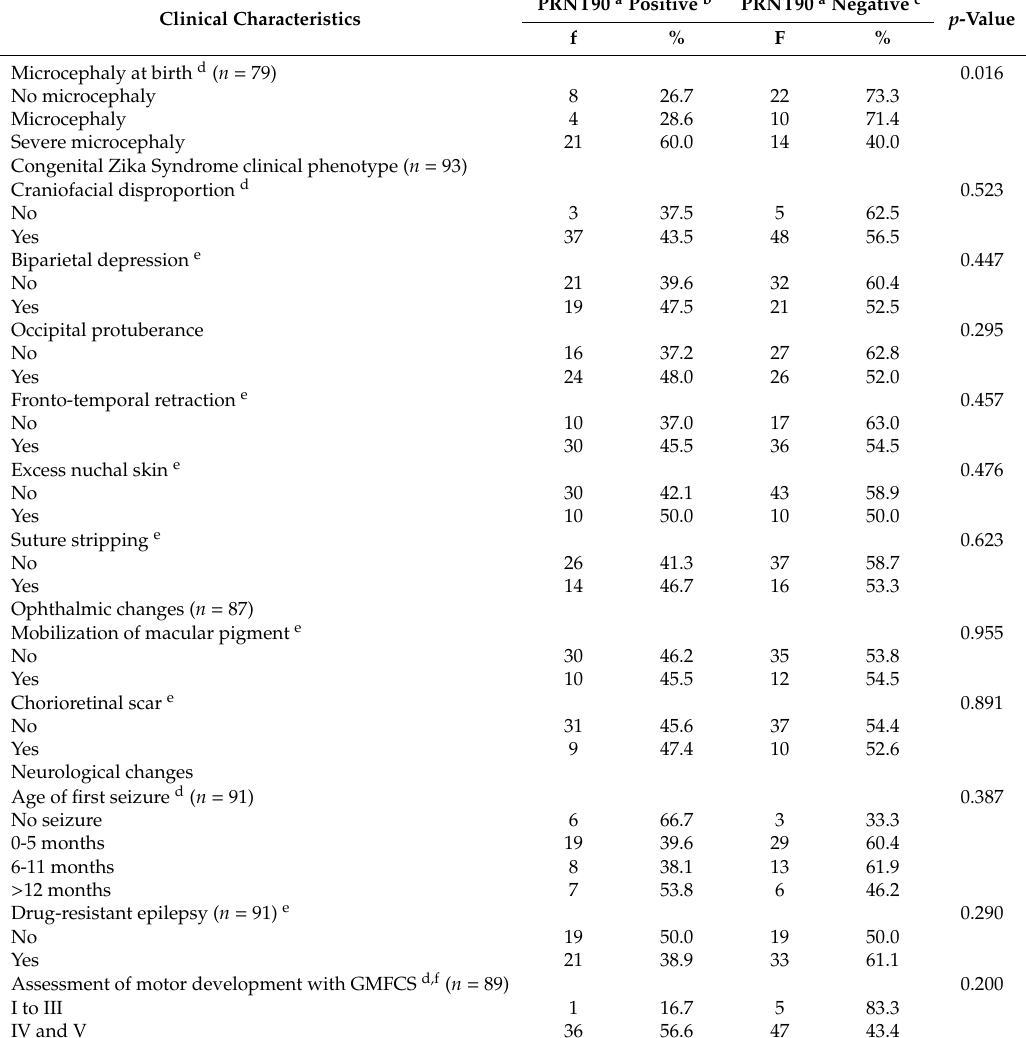
Table 3. Clinical and cranial tomography characteristics of children with CZS and positive and negative plaque reduction neutralization test. S ã o Lu í s, Brazil, 2016–2018. PRNT90 a Positive b PRNT90 a Negative c Clinical Characteristics p -Value f % F % Microcephaly at birth d ( n = 79) 0.016 No microcephaly